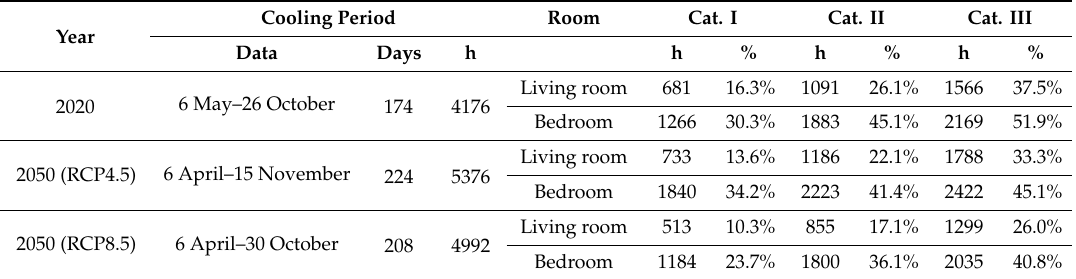
Table 6. Adaptive comfort assessment for the two analyzed rooms under di ff erent climate scenarios: comfort hours and percentages over the relevant cooling periods.